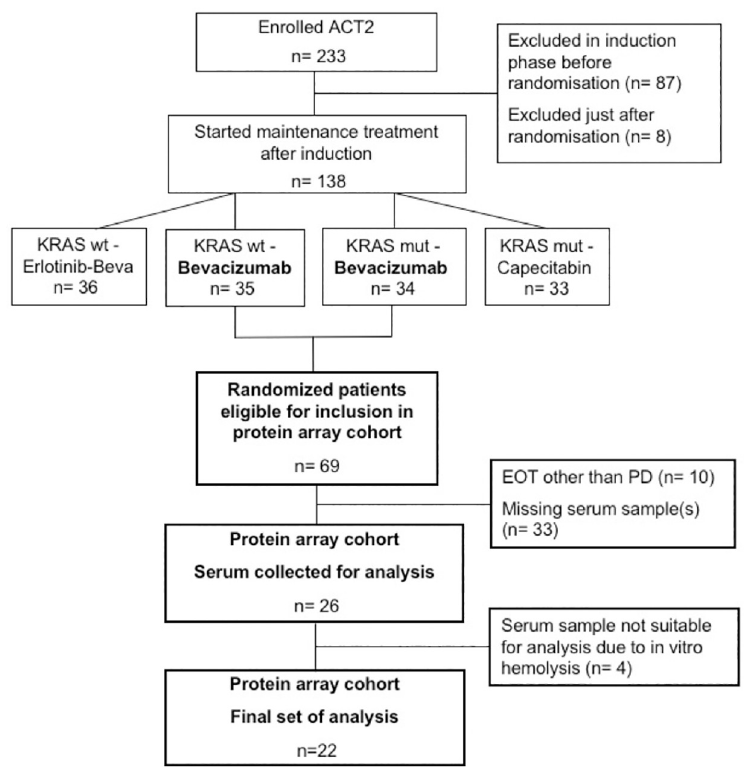
Fig 1. Patient flow chart. The induction treatment phase of the ACT2 trial consisted of chemotherapy plus bevacizumab for 18 weeks, and was followed by randomisation to maintenance treatment. KRAS, Kirsten Rat Sarcoma Viral Oncogene; wt, wild-type; mut, mutated; EOT, End of Treatment; PD, Progressive Disease.